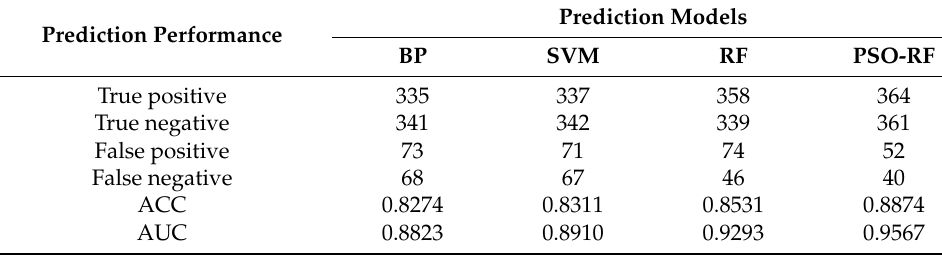
Figure 10. ROC curve and AUC value of the evaluation models. Table 7. AUC (Area Under the Curve) values and accuracy of the assessment model. Table 7. AUC (Area Under the Curve) values and accuracy of the assessment